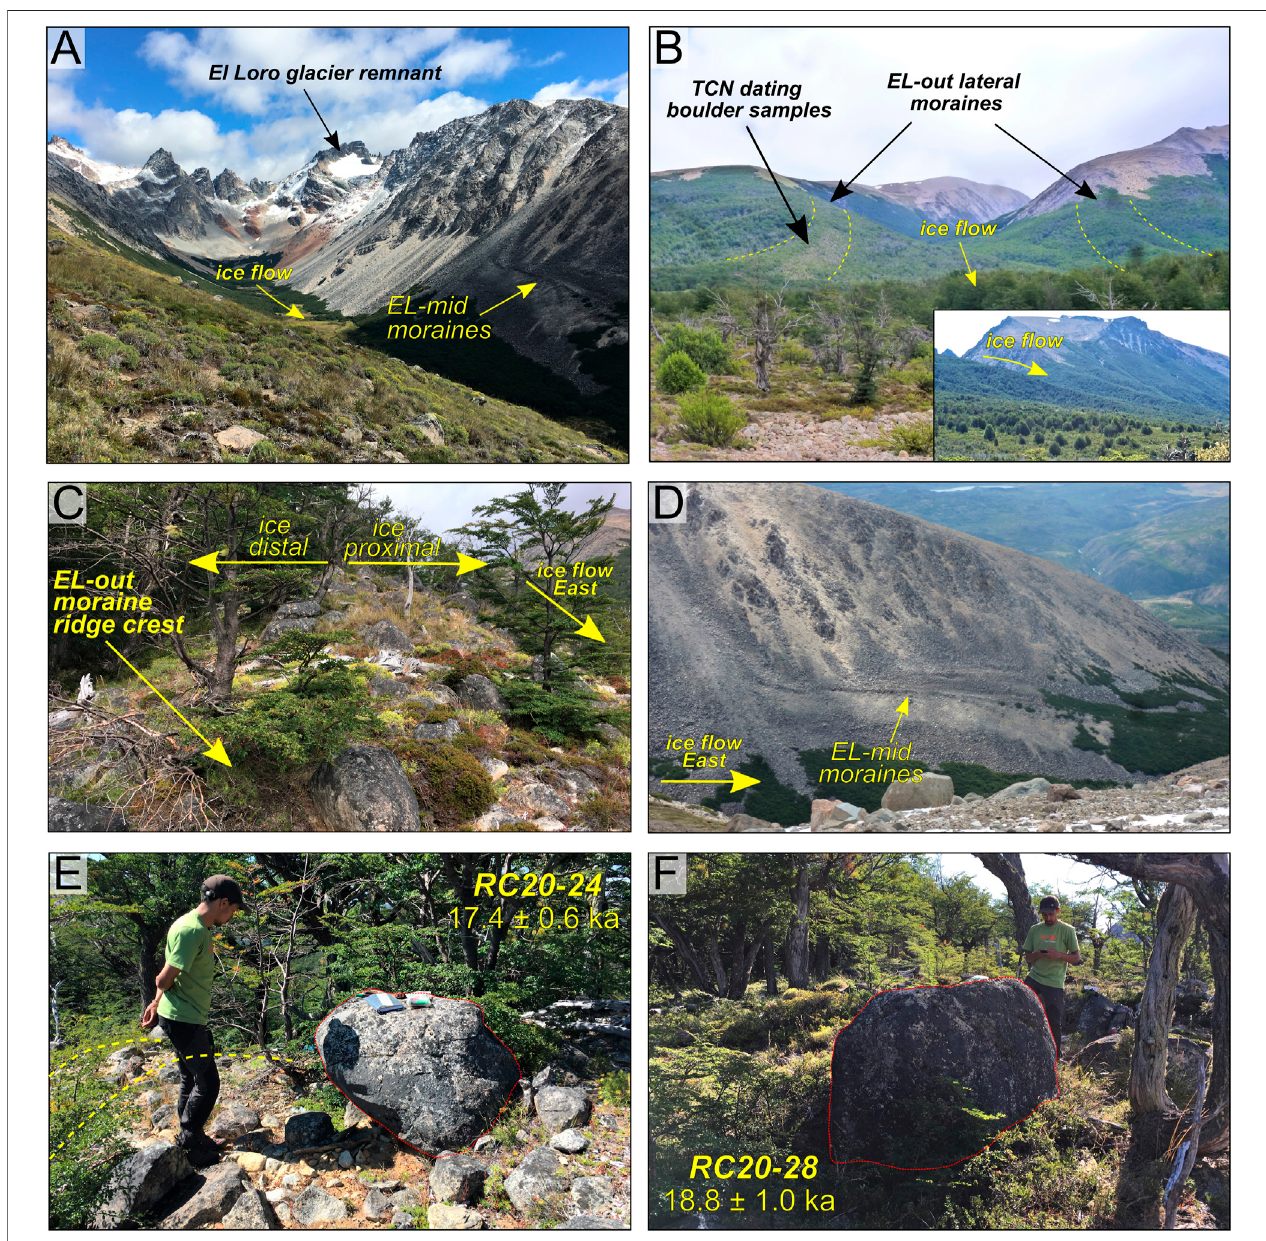
FIGURE 3 | Field photographs of the EL valley, moraines and sampled boulders. (A) Northwest-facing photograph of the EL valley and its upper catchment displayingtheEL-mid moraine ridges nestedonthenorthern valleyside. (B) WestwardviewoftheEL valleymouth from theprovincial road 44 (RP44).The EL-outlateral northern and southern (targeted for sampling) moraine ridges are highlighted by yellow dashed lines. The inset panel provides another, northward view of the same features from further a fi eld. (C) Westward-facing photograph captured from the EL-out southern lateral moraine crest (targeted for sampling), ilustrating moraine crestsharpness,ice-proximalandice-distalmoraine-slopeangles,moraine-surfacebouldersizes,roughlithologiesandconcentration. (D) Northwardviewoftheportion ofthenorthernELvalleysidedisplayingthepreservedEL-midmoraineridges. (E) South-facingphotographofanerraticgraniteboulder(sampleRC20-24,highlightedby red line) deposited on the crest of the EL-out southern lateral moraine ridge and sampled for TCN dating. The curvature of the moraine crest is highlighted by yellow dashed lines (F) West-facing photograph of an erratic granite boulder (sample RC20-28, highlighted by red line) sampled for TCN dating.